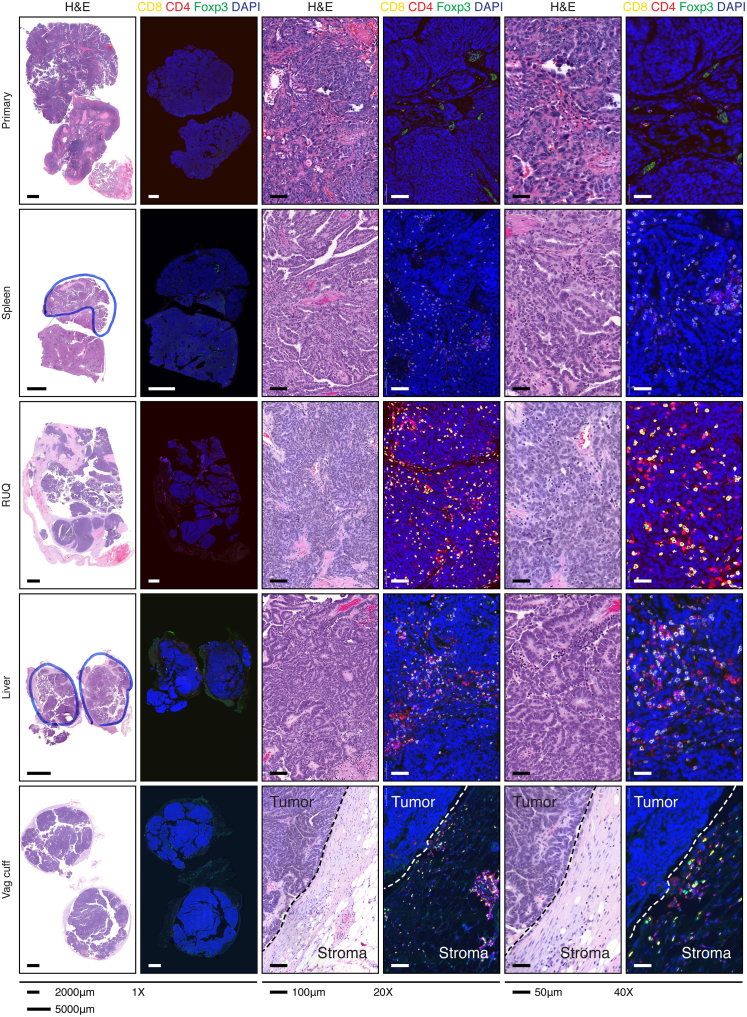
Complete Slide Hematoxylin and Eosin and Immunofluorescent Staining, Related to Figure 3 and Table S3Hematoxylin and eosin staining of tumor samples. Immunofluorescence staining for cytotoxic T cells (CD8+), helper T cells (CD4+FOXP3−), and regulatory T cells (CD4+FOXP3+).